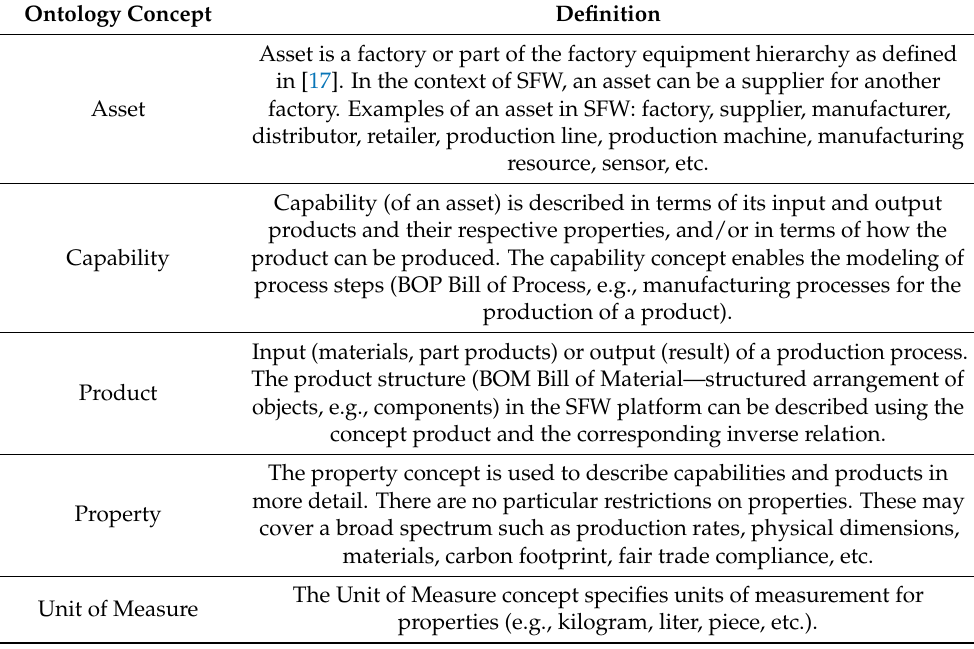
Table 5. Description of the ontology concepts.